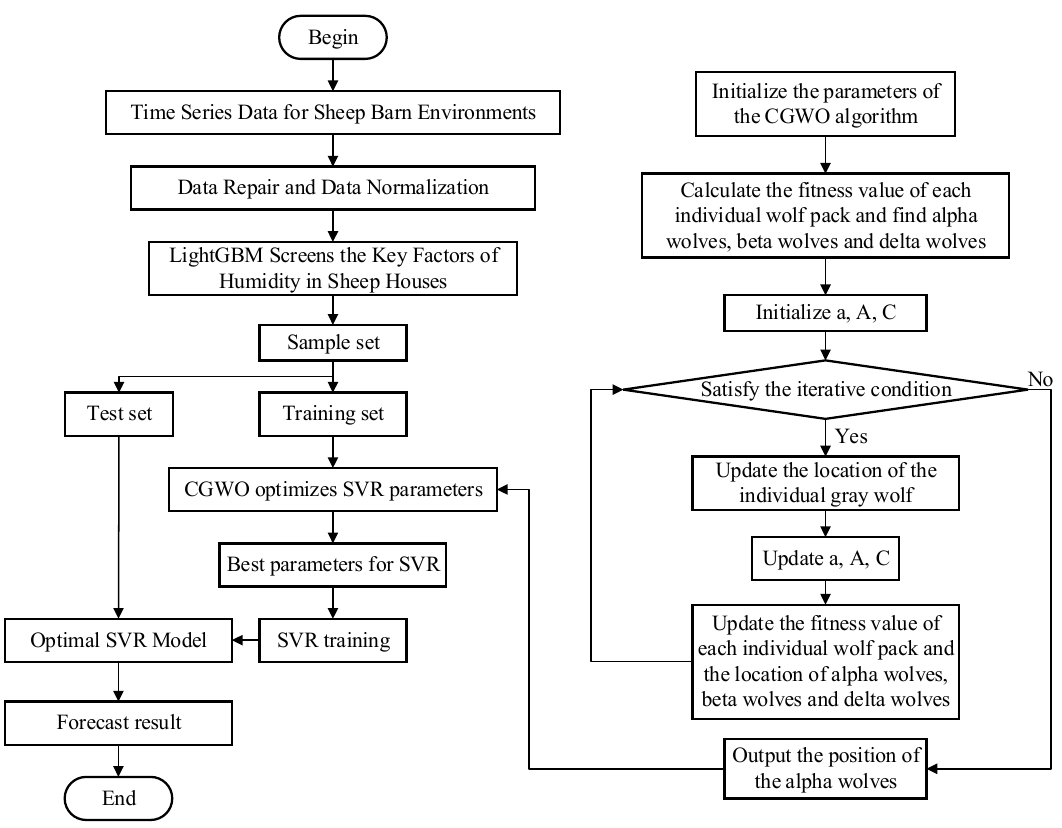
Figure 3. Flowchart of the LightGBM–CGWO–SVR algorithm.